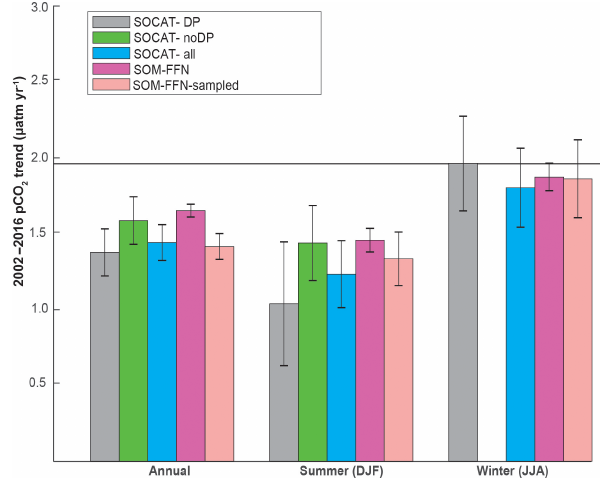
Figure 5. Surface ocean p CO 2 trends in the SPSS biome for years 2002–2016 (µatmyr − 1 ): SOCATv5 data within the Drake Passage box (gray); SOCATv5 data excluding data from the Drake Pas- sage box (green); SOCATv5 (blue); SOM-FFN product (magenta); SOM-FFN p CO 2 product sampled as SOCATv5 data in the Drake Passage box (light pink). The figure includes annual trends (left), austral summer trends (center) and austral winter trends (right). SOCAT-noDP winter trend omitted because it did not contain a JJA value for every year of the time series. For reference, the atmo- spheric p CO 2 trend during the 2002–2015 period (1.95µatmyr − 1 ) is shown as a horizontal black